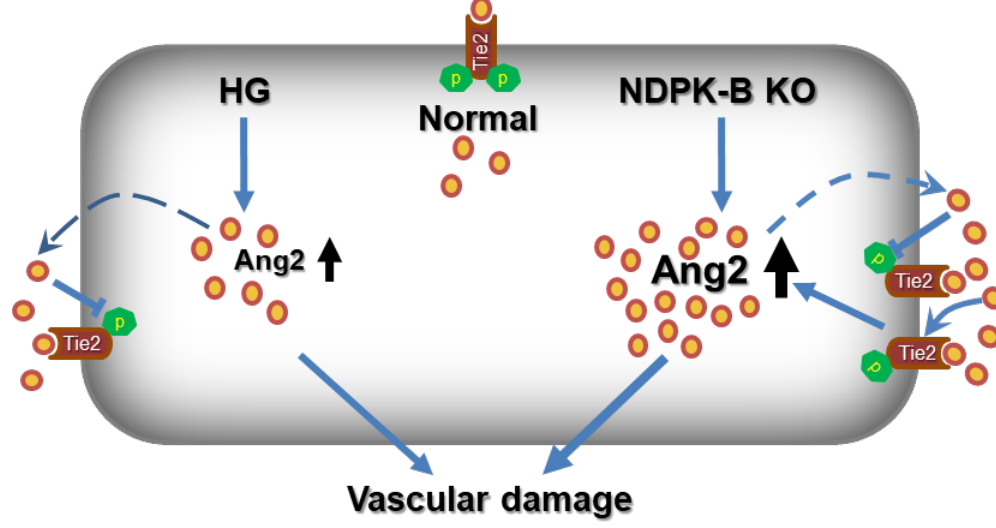
Figure 7. Model of the differential regulation of Ang2 via Tie2 in NDPK-B deficiency- and hyperglycemia (HG)-induced vascular regression. HG moderately upregulates the expression and secretion of Ang2, which contributes to vascular regression, via diminished Tie2 signaling. Similarly, NDPK-B deficiency induces upregulation and secretion of Ang2, which is also associated with a diminished proportion of activated Tie2. Under these conditions, however, the Ang2 levels reach a threshold in which the total amount of Tie2 is additionally increased. By its interaction with Tie2, Ang2 increases its own production and secretion in a positive feedback loop which might be an important driving force in NDPK-B deficiency-induced vascular regression.